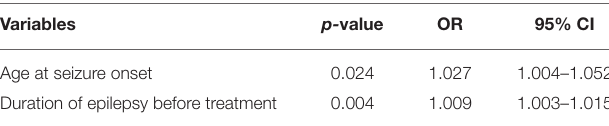
TABLE 5 | Multivariate logistic regression analysis of the demographic and clinical variables between the monotherapy and polytherapy groups. Variables p- value OR 95% CI Age at seizure onset 0.024 Duration of epilepsy before treatment 0.004 1.009